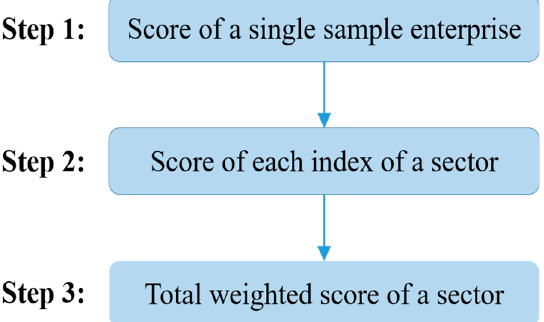
Figure 4. Calculation steps for the score of a sector’s digital transformation.